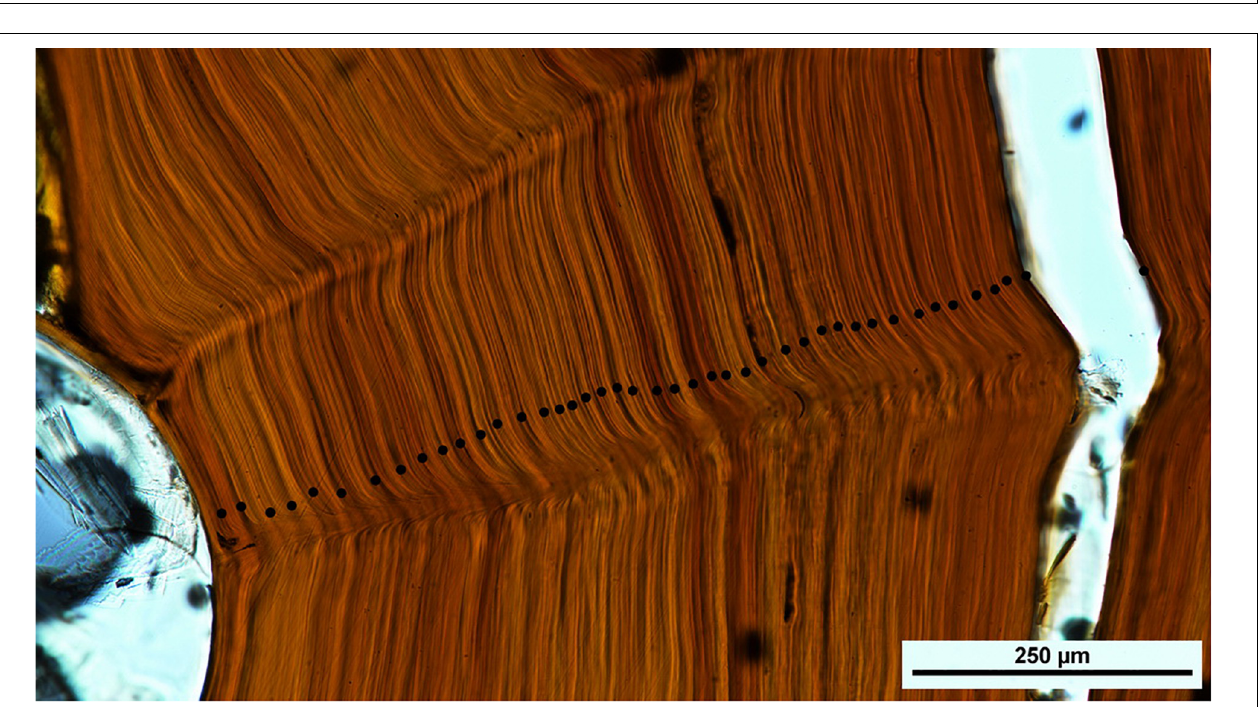
FIGURE 7 | Central portion of the basal section of coral NIWA47911 showing the fine scale interpretation protocol of the observed zone structure. The specimen shows 42 zones marked with black dots across this inner region of the section; the whole section showed 211 zones.